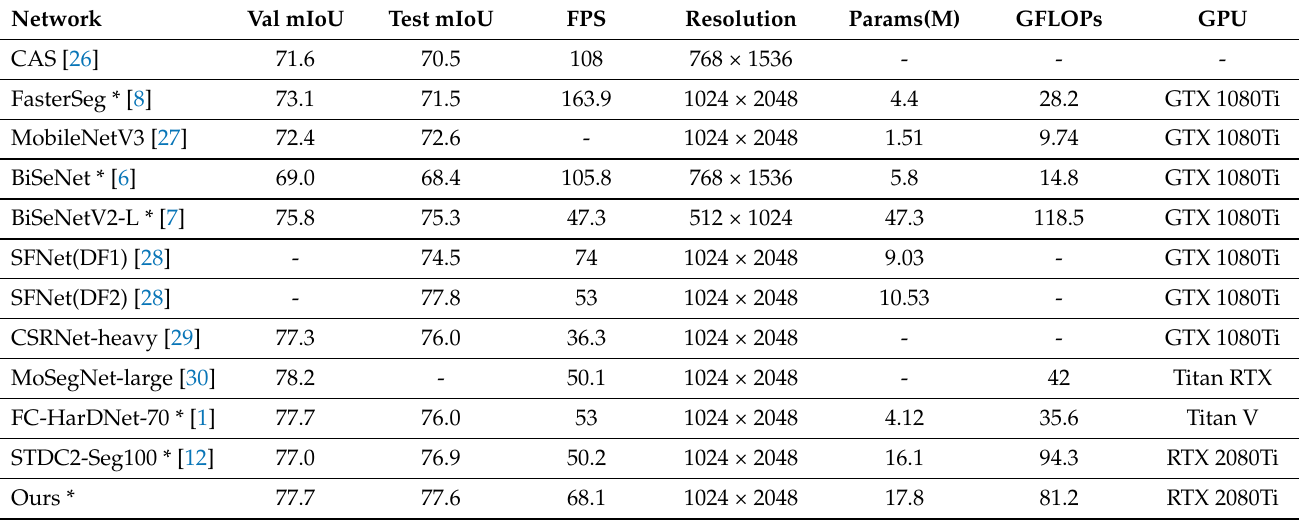
Table 4. Comparison of the accuracy and speed of different networks on Cityscapes val set. * means using TensorRT.